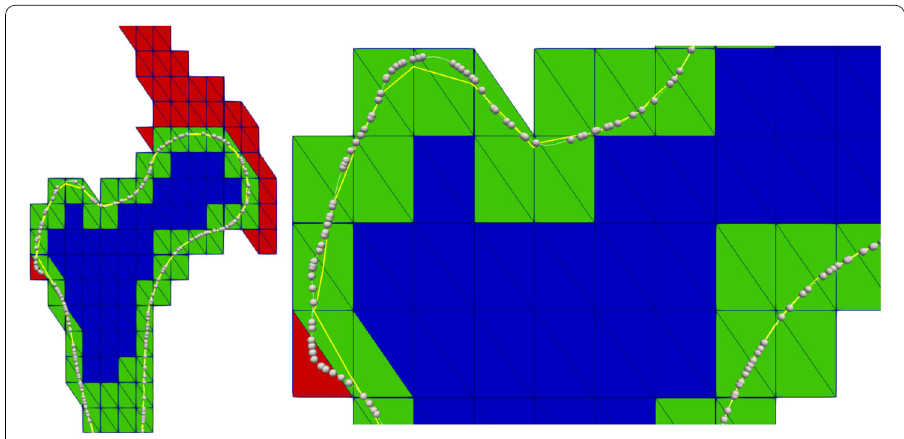
Fig. 4 Linear approximation of the geometry (zero level set contour) given a surface triangulation for the femur bone. The grey balls indicate the nodes of the original surface triangulation. All elements with positive level set values in all their nodes are shown in red, all elements with a change in sign of the level set value (containing the zero contour line of the level set function) are shown in green and all elements with negative level set values in all their nodes are shown in